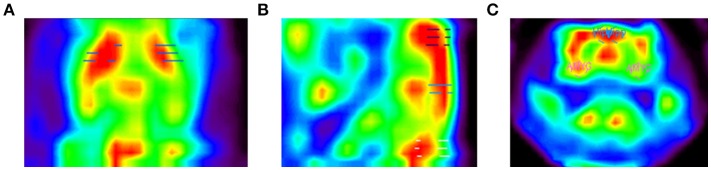
PET images of the rat brain. Depicted are (A) a horizontal slice through the brain showing the striatum ROI, (B) a sagittal slice showing themotor cortex ROI on top (purple dashes), hippocampus ROI in the center (blue dashes), and cerebellum ROI at the bottom (white dashes), and (C) a coronal slice showing the hippocampus (blue circles) and amygdala ROIs (pink circles).